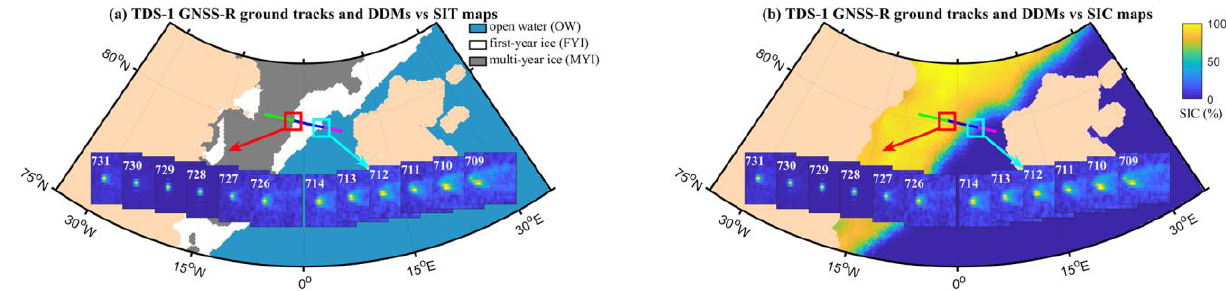
Figure 2. Typical TechDemoSat-1 (TDS-1) Delay-Doppler Maps (DDMs) collected over ( a ) sea ice type (SIT), which includes open water (OW), first-year ice (FYI), and multi-year ice (MYI)) and ( b ) sea ice concentration (SIC) maps on 26 November 2015. The magenta, blue and green plots represent the ground tracks of OW, FYI, and MYI respectively. The continuous DDMs from index 709 to 714 for the OW-FYI transition area is marked with the cyan rectangle. Similarly, the FYI-MYI transition area with DDMs from index 726 to 731 is presented in the figure. The SIT and SIC maps are obtained from the Ocean and Sea Ice Satellite Application Facility (OSISAF). The OW is depicted by the light blue color. FYI and MYI are demonstrated by white and gray respectively in Figure 2a.